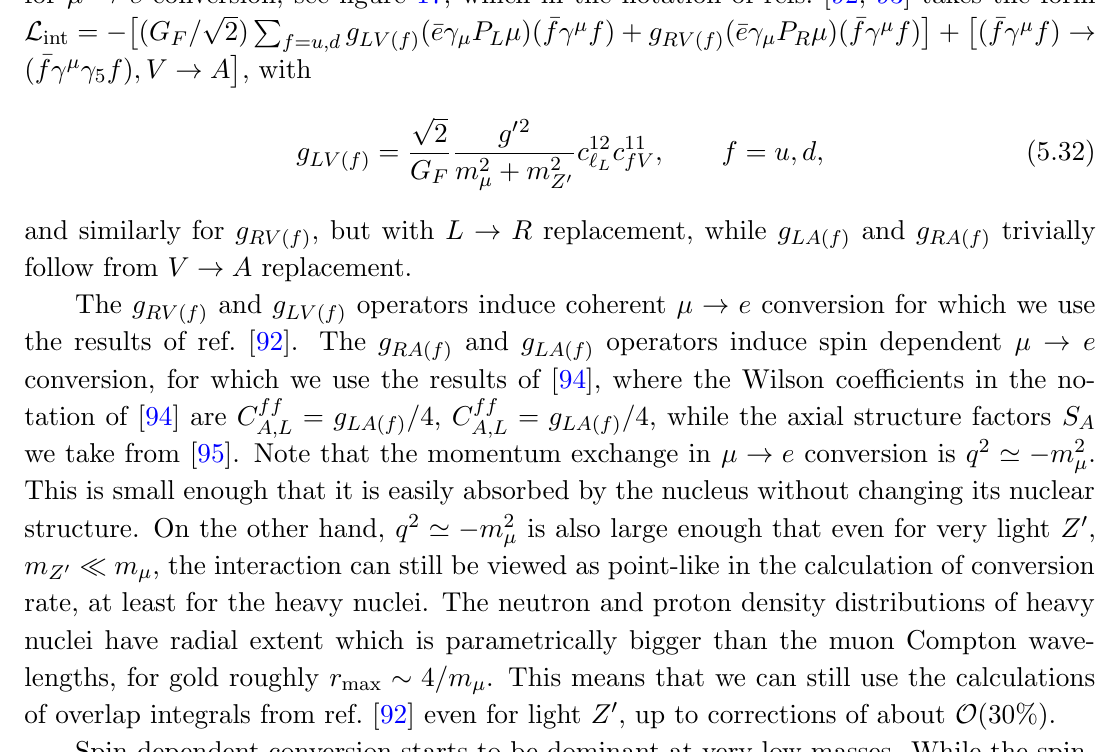
Figure 17 . Lepton (cid:13)avor violating diagrams induced by a Z 0 exchange. Left : (cid:22) Center : decay to three leptons, ‘ i (cid:22) ! e